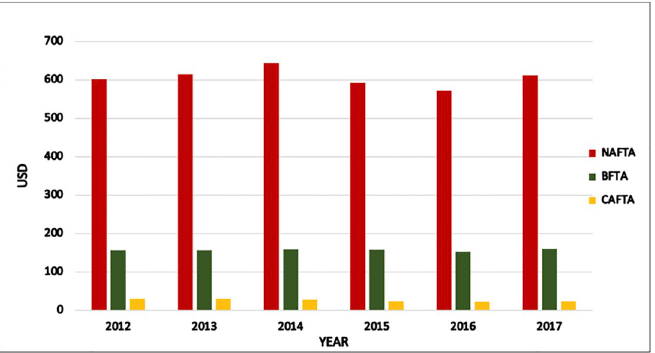
Fig 2. Total imports to the United States from all FTAs (NAFTA, BFTA, and CAFTA-DR) from 2012 to